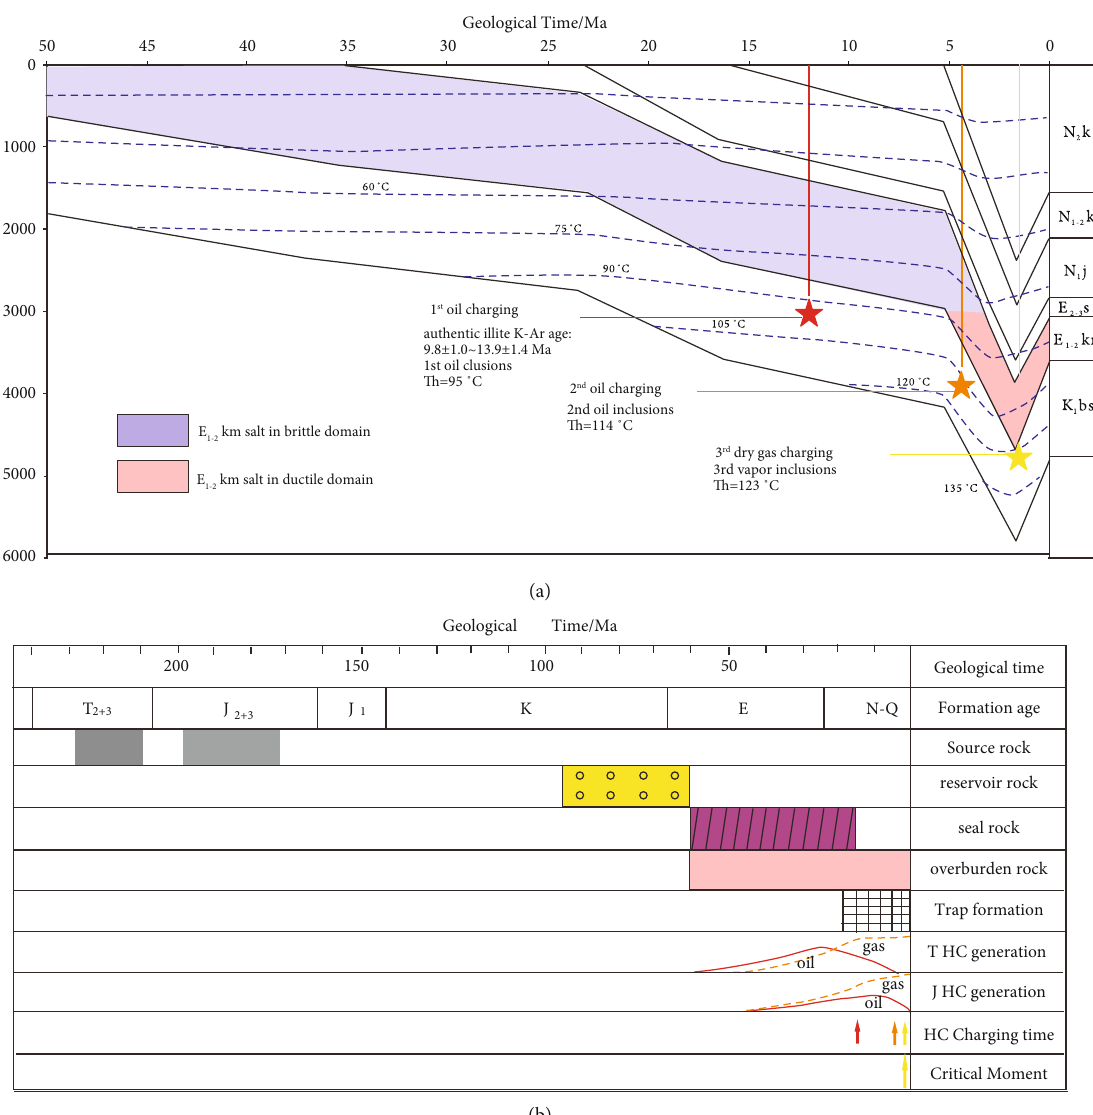
Figure 8: Burial and geological history for the Kela 2 gas fi eld, showing hydrocarbon charging periods. (a) Burial and thermal history diagram for well KL2, showing the three periods of oil and gas charging according to fl uid inclusion analysis. (b) Petroleum system history for the Kela-2 gas fi